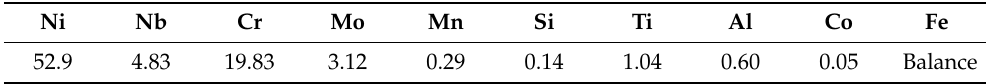
Figure 1. A scheme ( a ) and a photo ( b ) of the experimental setup (1—sample, 2—processing laser beam, 3—mechanical loading system, 4—flat plate, 5—laser-optical triangulation distance sensor). Table 1. Chemical composition (wt%) of Inconel 718.